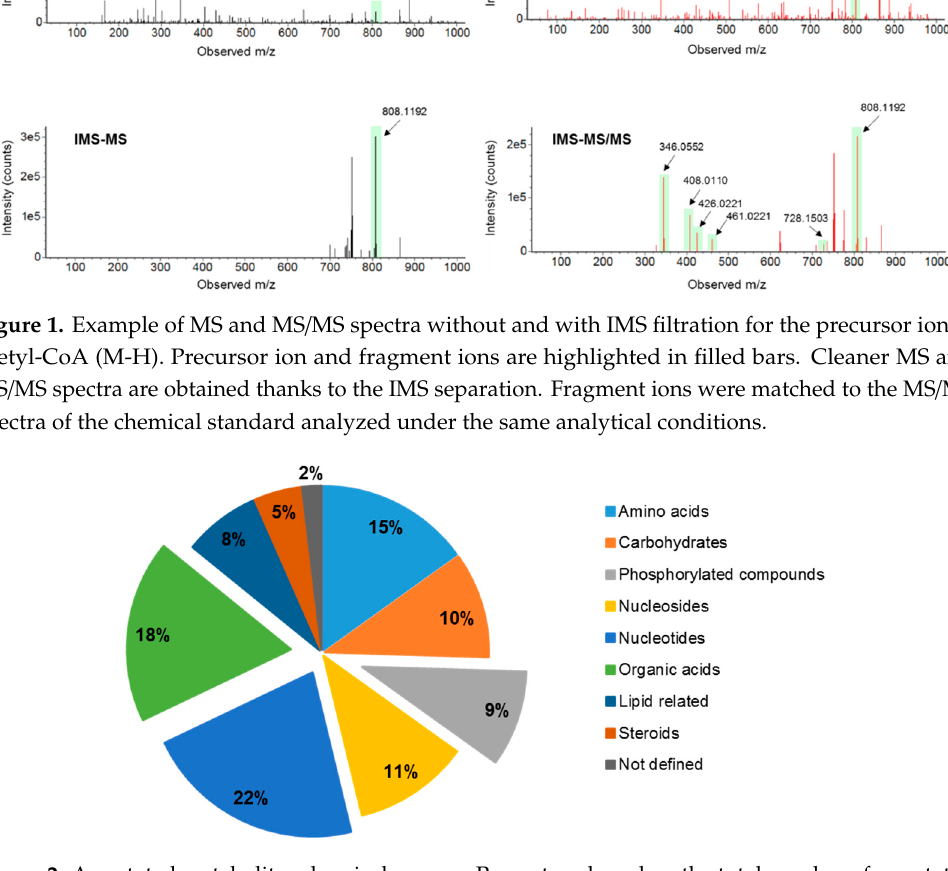
Figure 2. Annotated metabolites chemical groups. Percentage based on the total number of annotated metabolites (106).